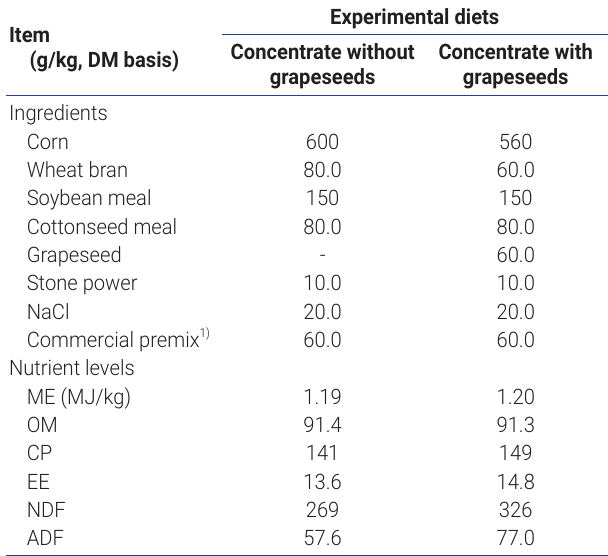
Table 2. Ingredients and chemical composition of the concentrate